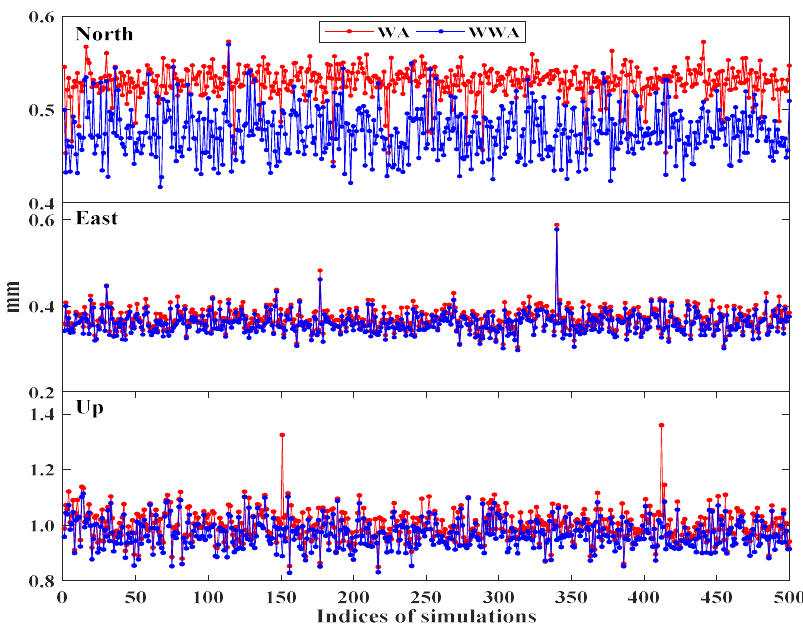
Figure 12. RMSEs of 500 simulations of the WA and WWA.